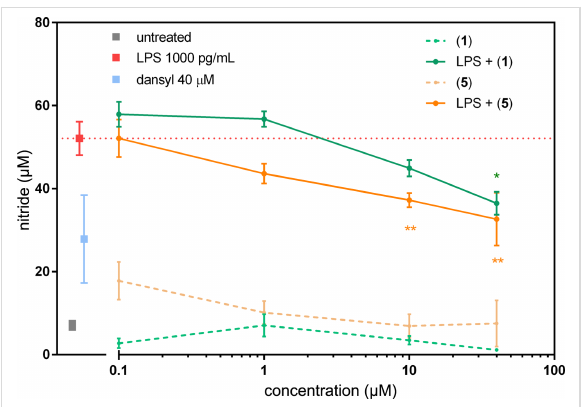
Figure 8: NO production in primary rat macrophages. The cells were treated with archangelolide ( 1 ) and dansylarchangelolide 5 in the con- centration range of 0.1–40 µM for 24 h with or without lipopolysaccha- ride (LPS, 1000 pg·mL − 1 ) or with solely 40 µM dansyl amide. The results represent the mean ± SEM of three independent experiments, n = 6. Statistical significance: * P < 0.01, ** P < 0.001, the results of the compounds are statistically different from those of the LPS-treated cells.